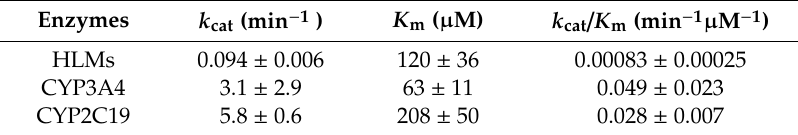
Table 1. Kinetic parameters of phloretin hydroxylation via human liver microsomes (HLMs), CYP3A4, and CYP 2C19.